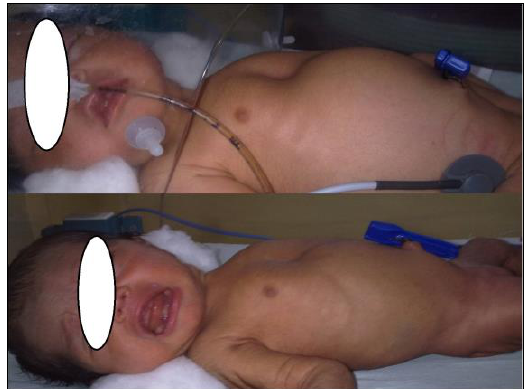
Figure 1: (a) Clinical photographs of the neonate with ab- dominal distension (top). (b) Clinical photograph after reso- lution of spontaneous Pneumoperitoneum (bottom).